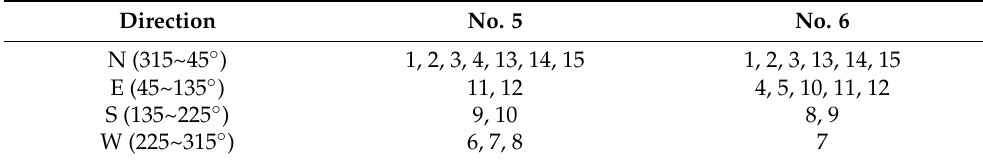
Table 5. Grouping of wind turbines by wind